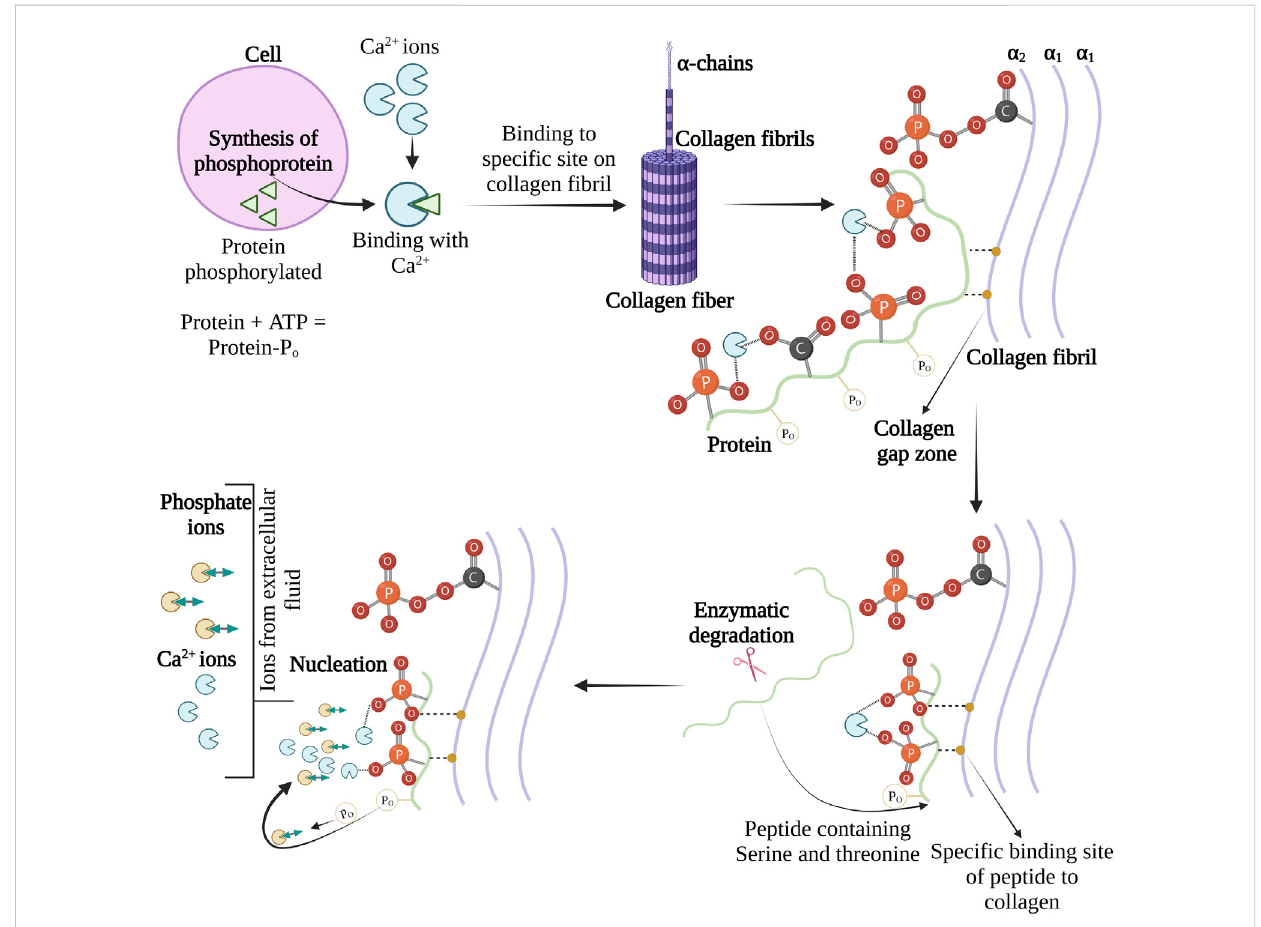
FIGURE 6 Schema for the role of phosphoproteins inter fi brillar collagen mineralization. The image is inspired by the artwork of (Glimcher,